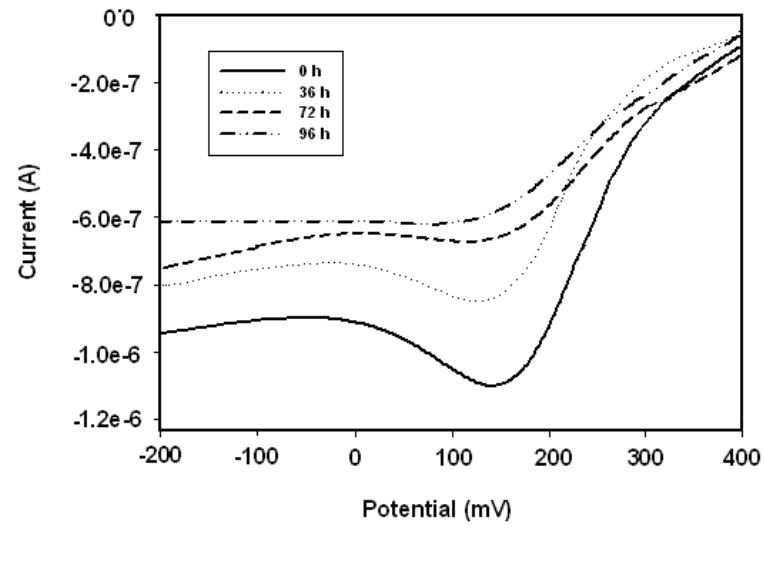
Figure 9. Rate of change of square wave responses of the Pt/PANI:PESA/HRP biosensor to 5.0 µM H O 2 2